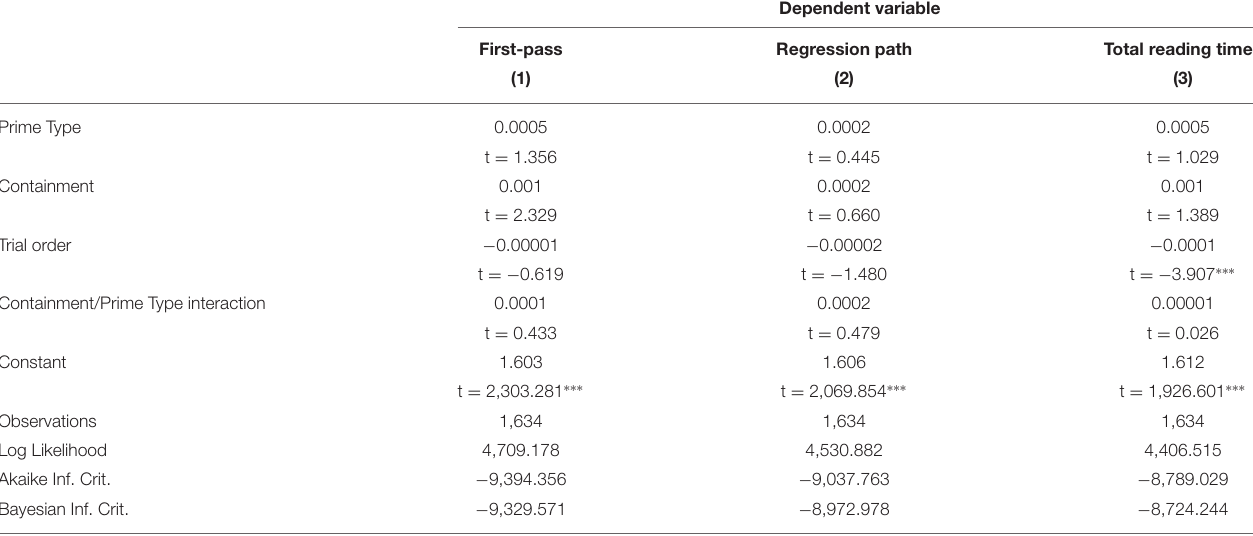
TABLE 7 | Regression analysis of reading times in the ADJECTIVE region of Experiment 2.